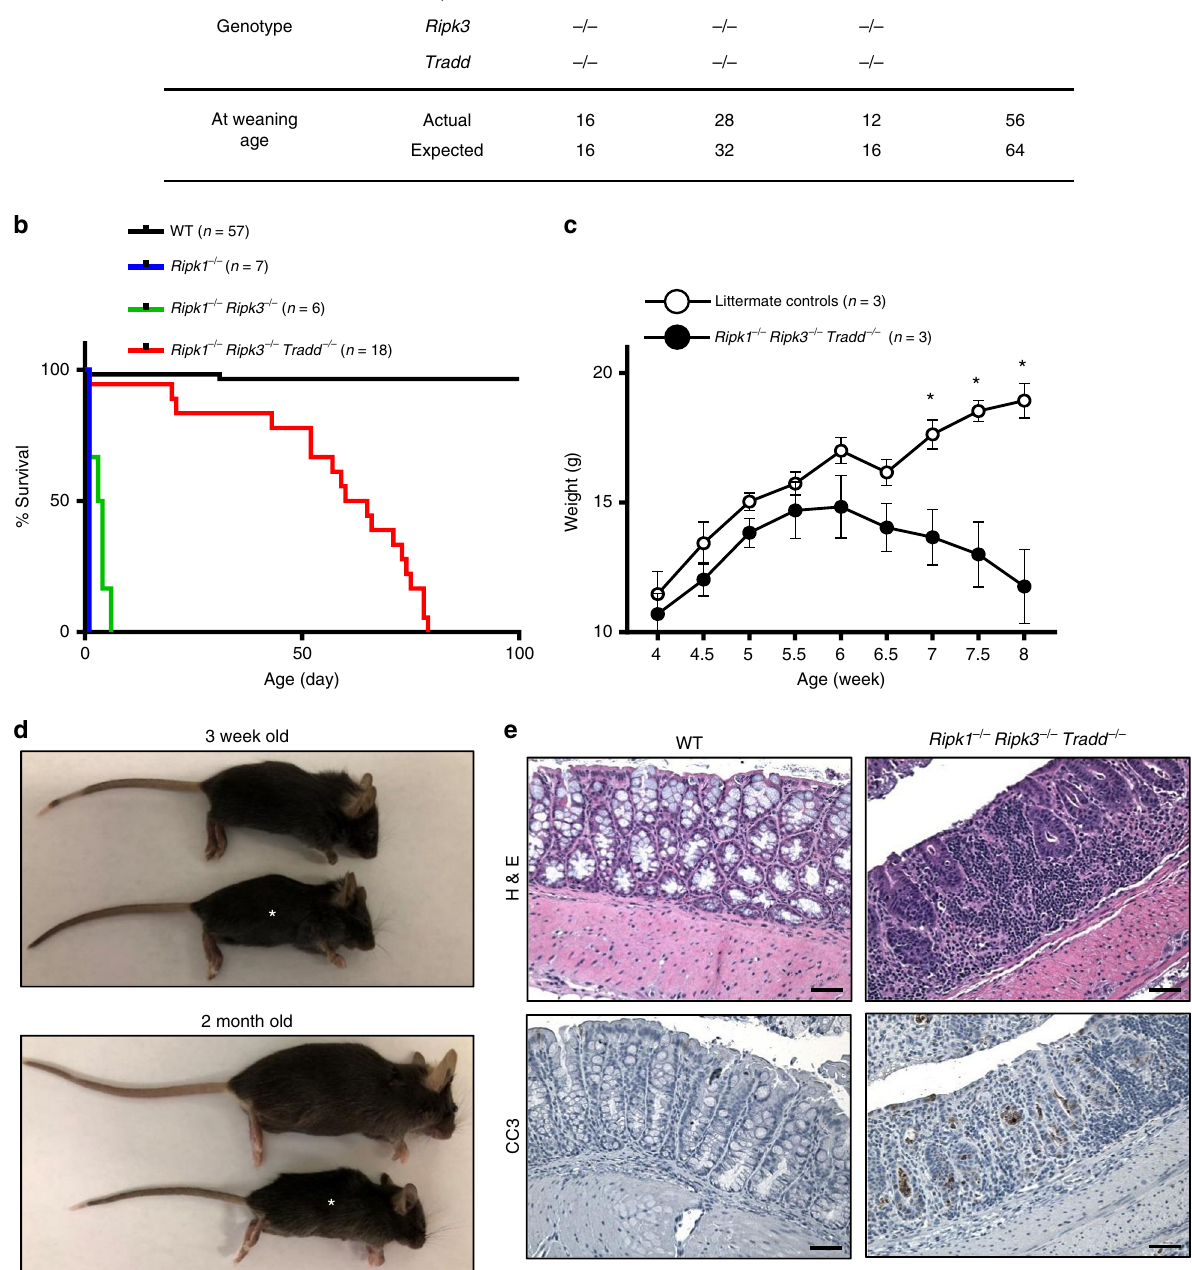
Fig. 1 Deletion of TRADD improves the survival of Ripk1 − / − Ripk3 − / − into young adulthood. a Actual and expected frequencies of pups at weaning age from intercrosses of Ripk1 + / − Ripk3 − / − Tradd − / − mice. Chi square analysis shows no signi fi cant difference between actual and expected ( p = 0.472). b Kaplan – Meier plot showing survival of mice of indicated genotypes. Logrank tests shows a signi fi cant increase in survival of Ripk1 − / − Ripk3 − / − Tradd − / − mice, compared to Ripk1 − / − Ripk3 − / − mice ( p < 0.0001) but signi fi cantly less than WT mice ( p < 0.0001). c Weights of Ripk1 − / − Ripk3 − / − Tradd − / − mice and littermate controls over time presented as mean ± SEM, * p < 0.05 as determined by Student ’ s t test. d Three week old and two month old Ripk1 − / − Ripk3 − / − Tradd − / − mice (*) with littermate controls ( n = 5 independent experiments). e Hematoxylin and eosin (H&E) and cleaved caspase 3 (CC3) staining of the large intestine of indicated genotypes ( n = 3 independent experiments). Scale bars are 50 μ